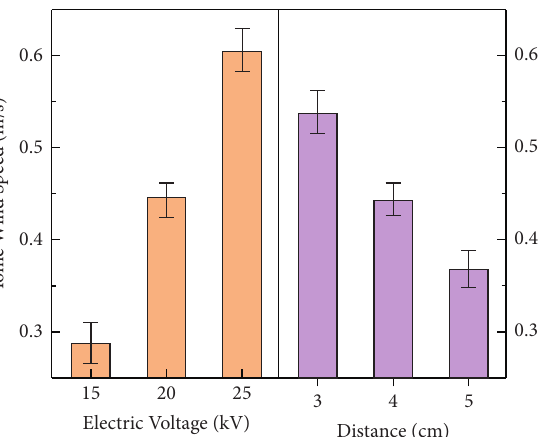
Figure 4: Ionic wind speeds at (a) needle-dielectric plate distance of 4 cm and voltages of 15, 20, and 25kV and (b) voltage of 20kV and needle-dielectric plate distances of 3, 4, and 5 cm.